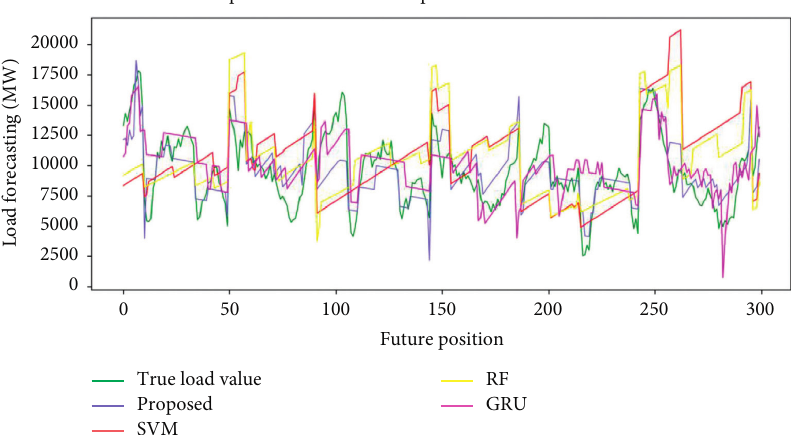
Figure 8: Model prediction comparison